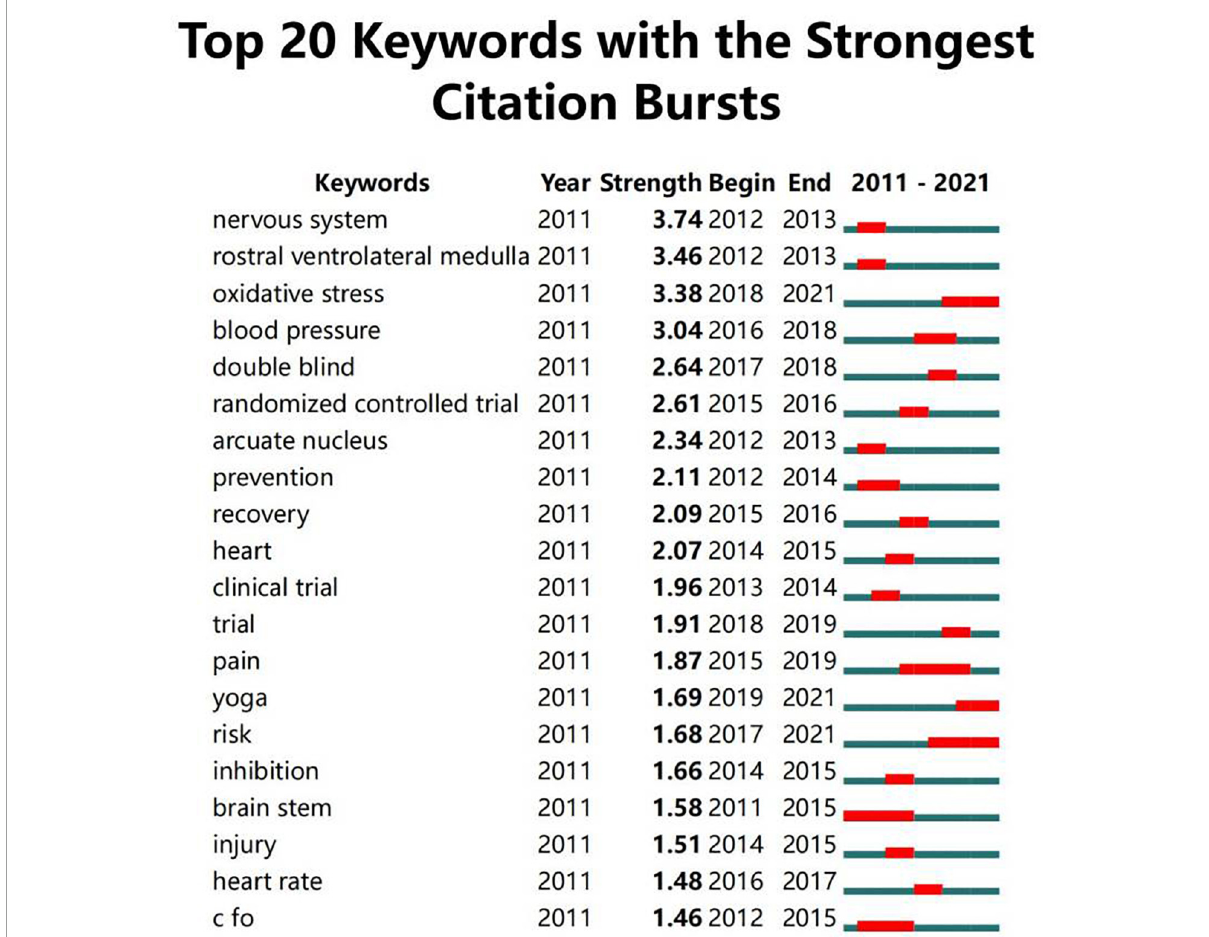
FIGURE9 The top 20 keywords with the strongest citation bursts about acupuncture on